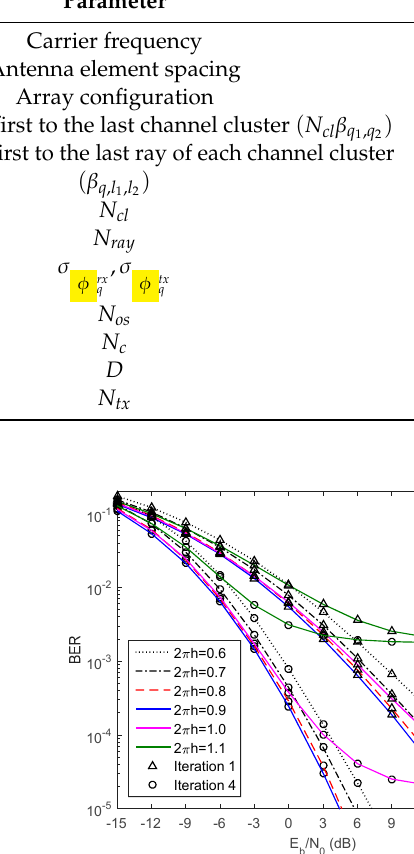
Figure 3. Performance comparison of the proposed iterative hybrid equalizer with N RF rx = U = 8, and N rx = 32 for different modulation indexes.